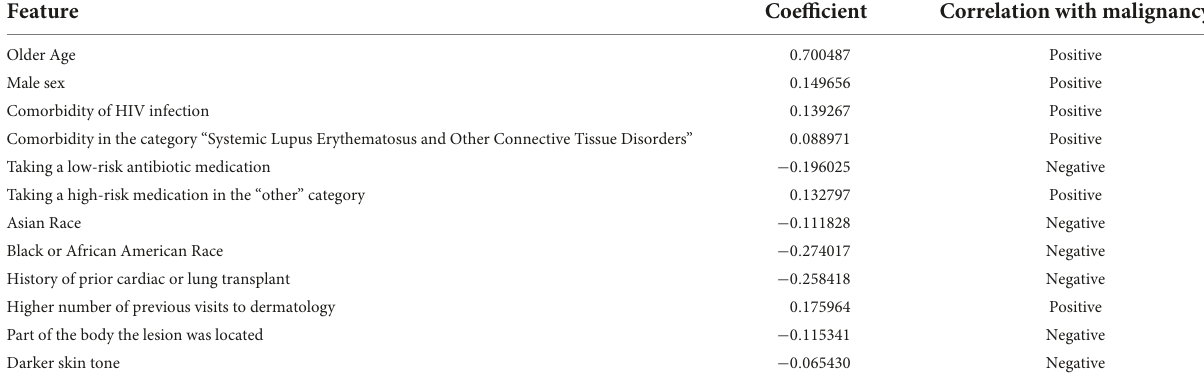
TABLE 2 Coefficients and associations for demographic and clinical features relevant for informing the combined image and clinical data model. Feature